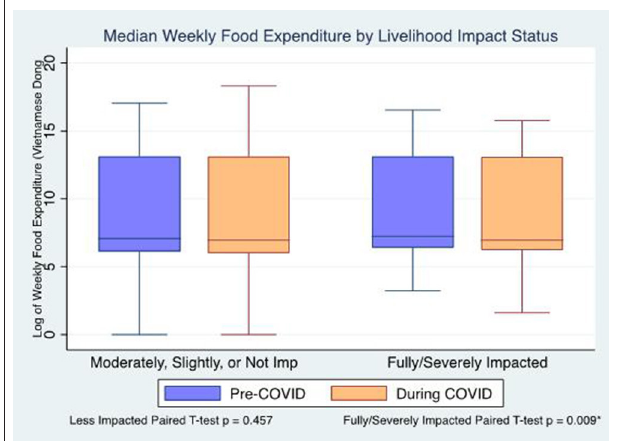
FIGURE 1 | Weekly food expenditure prior to and during the COVID-19 pandemic by livelihood impact group.